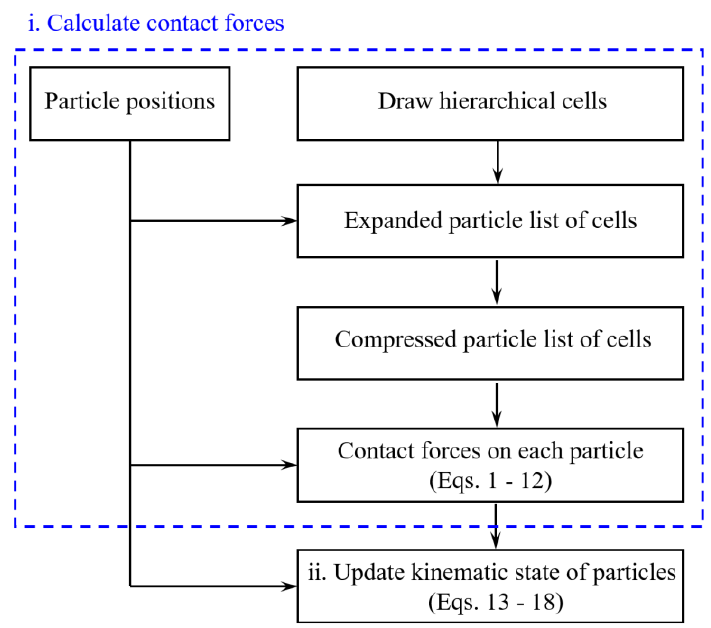
Figure 3. Flowchart of parallelisation operations in each incremental step.